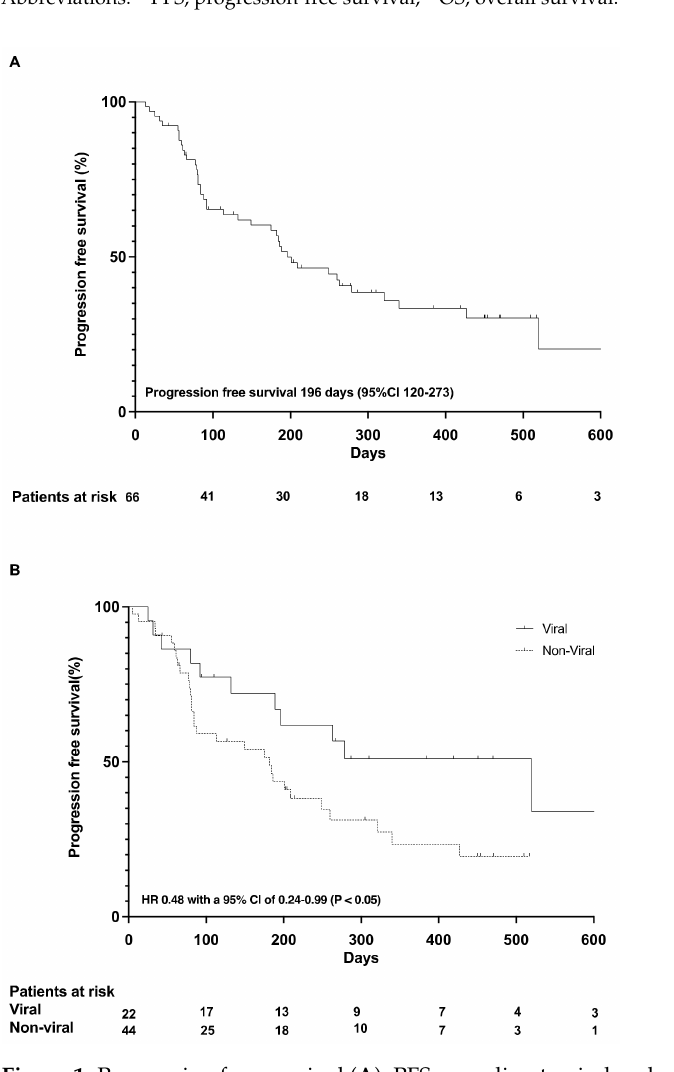
Figure 1. Progression free survival ( A ); PFS according to viral and non-viral etiology ( B